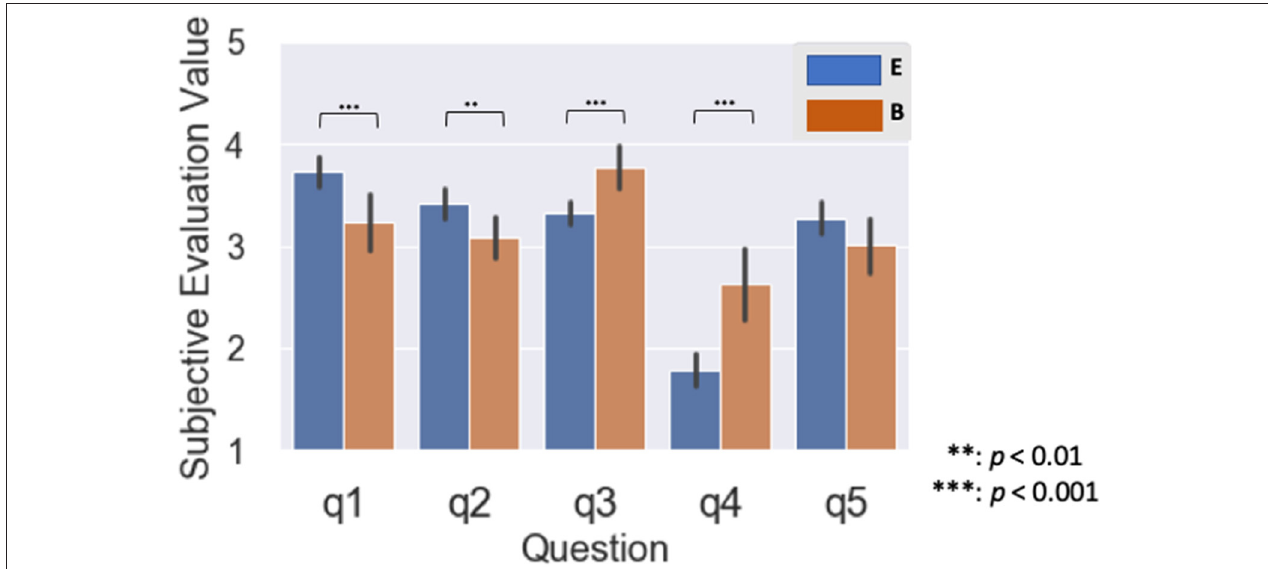
FIGURE 4 | Mean of subjective evaluation value for two groups with different years of simultaneous interpretation (SI) experience: Experienced group with over 15 years was represented as E, and a beginner group with < 1 year was represented as B. All questions were rated on five levels of interpretation difficulty: level 1: participants felt interpretation was easy; level 5: participants felt interpretation was